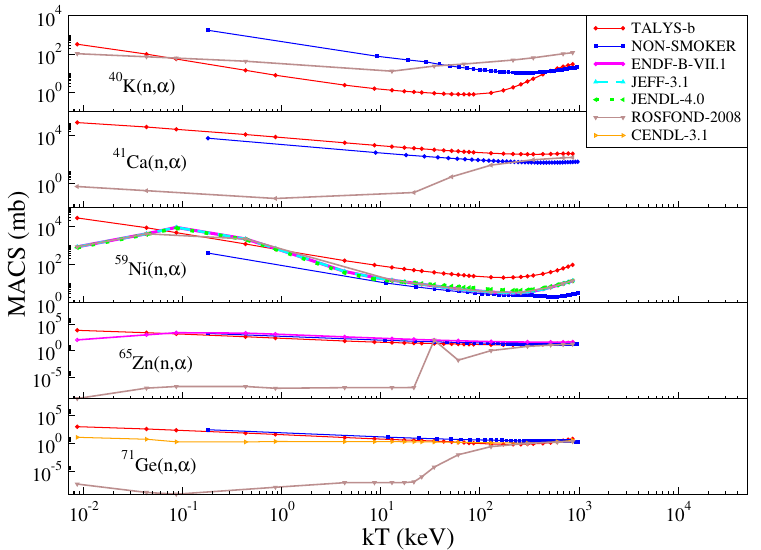
Figure 5. The same as in Figure 4, but for 40 K, 41 Ca, 59 Ni, 65 Zn, and 71 Ge target nuclei. In addition to the results from other data sets, comparison with the MACS values from the CENDL-3.1 [12] nuclear data library is also